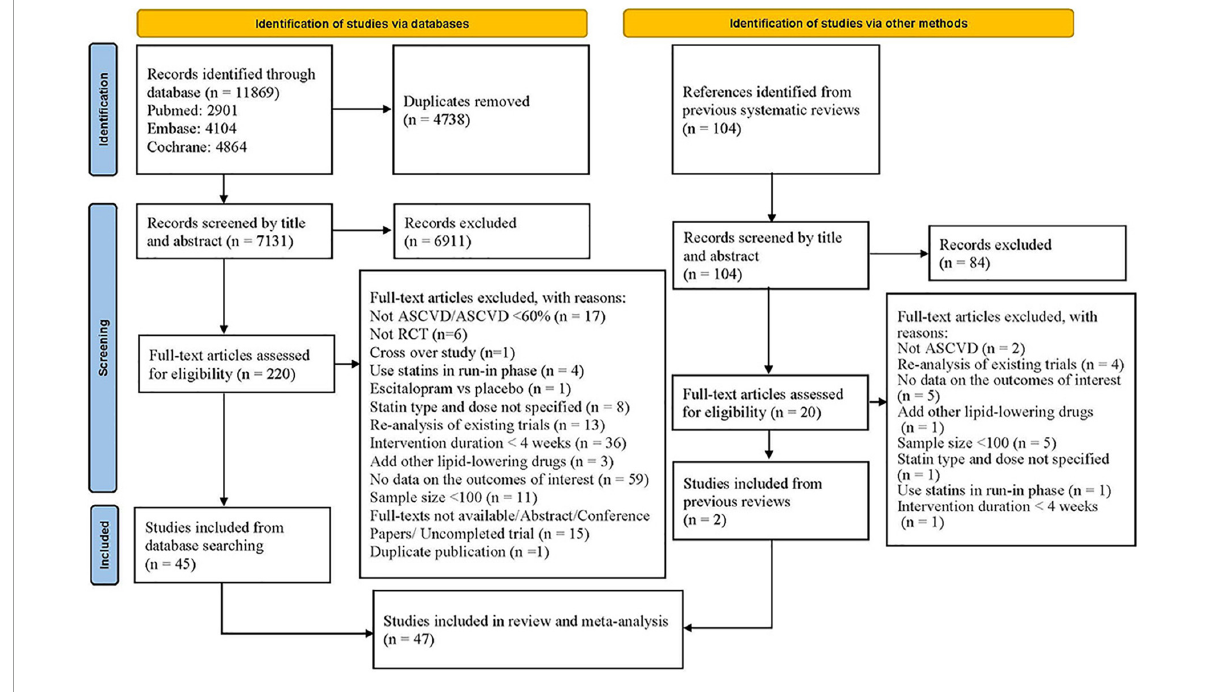
FIGURE1 Flowchart of study selection.